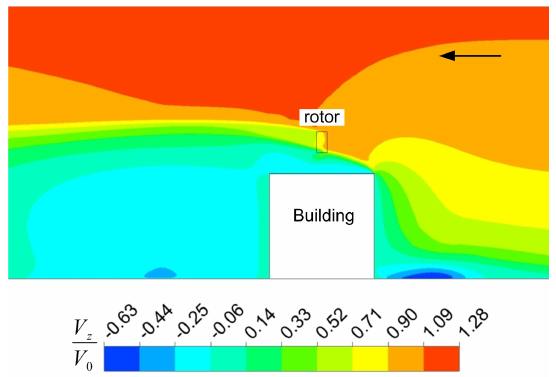
Figure 7. Normalized velocity (perpendicular to rotor axis) with the free stream from a hybrid rotor and building model. The case shown is for a turbine height, which is 1.3-times the building height. The interaction of the rotor and building wakes are clearly visible. Adapted from Micallef et al.